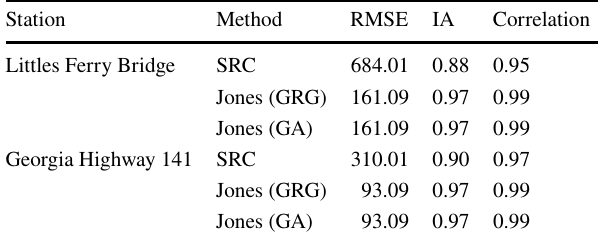
Fig. 1 Tracing the looped rating curve of Littles Ferry Bridge using GRG